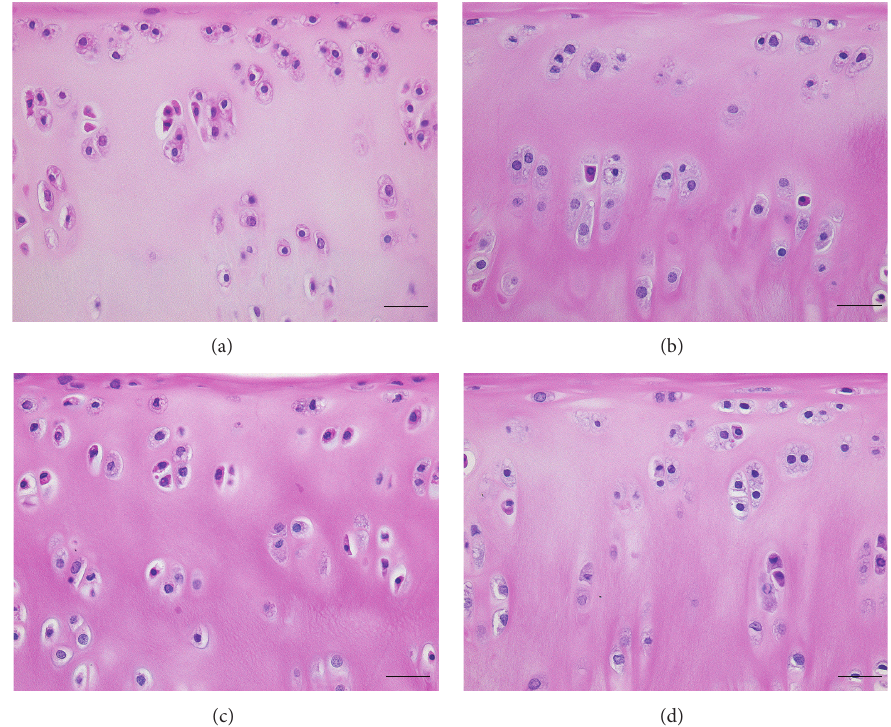
Figure 1: Representative hematoxylin and eosin stained tissue sections of OCTs cold preserved in the presence and absence of hyaluronic acids. Histological analysis of OCTs was performed after 2 weeks of preservation in UW (a), UW with HA800 (b), UW with HA1900 (c), and UW with HA6000 (d). Scale bar, 50 𝜇 m.